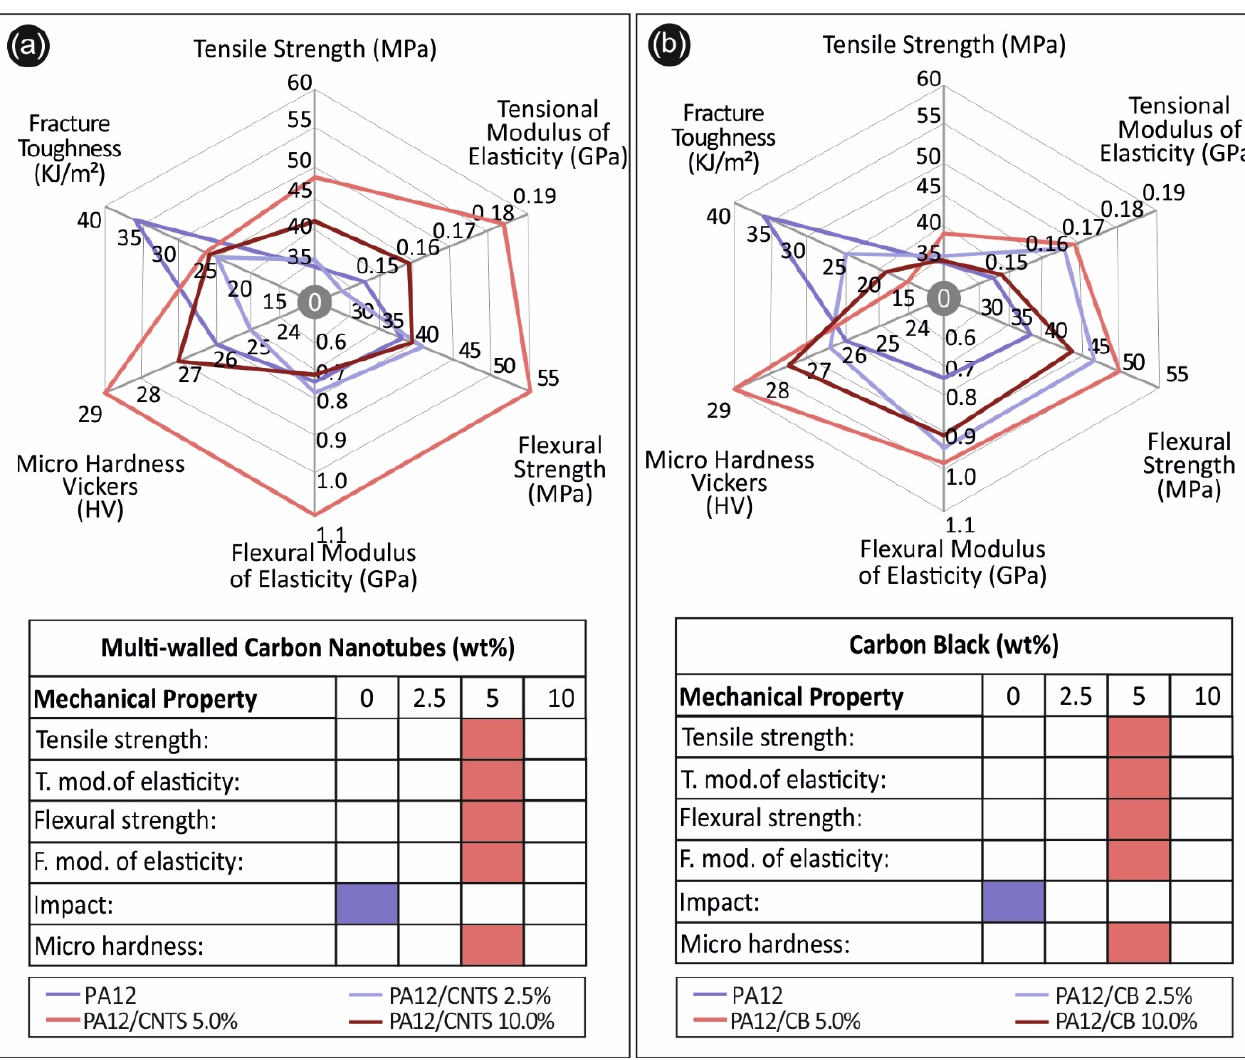
Figure 15. Overall results on the mechanical properties and performance of neat PA12, compared to ( a ) PA12/CB and ( b ) PA12/CNT 3D ‐ printed nanocomposites.